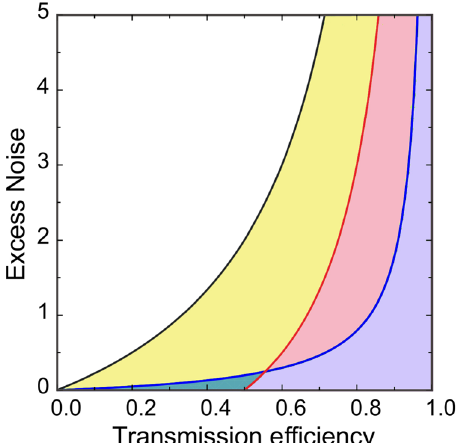
Fig. 5 The region plot parameterized by transmission ef fi ciency and excess noise. The region below the black curve, which is the bound of entanglement sudden death, represents the existence of the entanglement. The region below the blue and red curves, which are the bound of the disappearance of G A ! B and G B ! A , respectively, represents the existence of EPR steering.